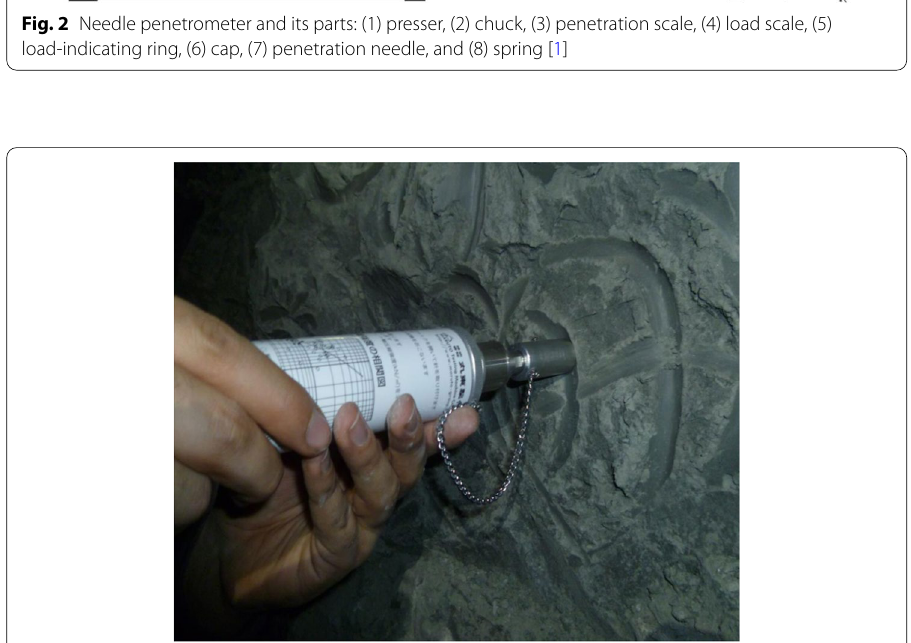
Fig. 3 Performing needle penetration test at the gallery